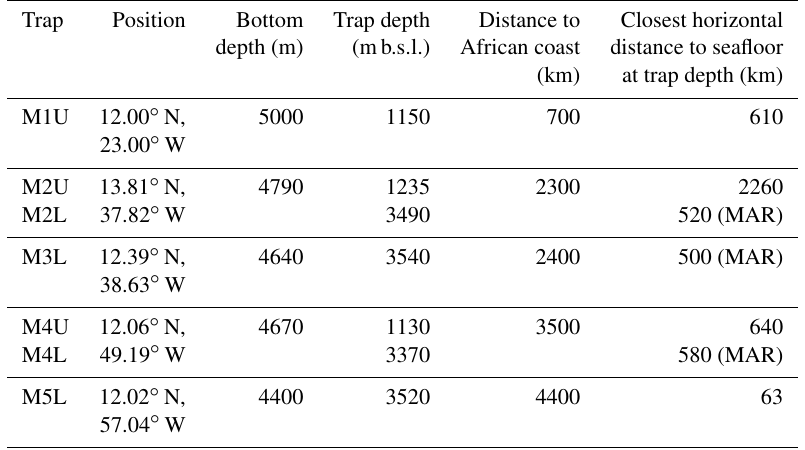
Table 2. Sediment trap details. Sampling was performed simultaneously and synchronously from 19 October 2012 until 7 November 2013 (384 days). Trap Position Bottom Trap depth Distance to Closest horizontal depth (m) (mb.s.l.) African coast distance to seafloor (km) at trap depth (km) M1U 12.00 ◦ N, 5000 1150 700 610 23.00 ◦ W M2U 13.81 ◦ N, 4790 1235 2300 2260 M2L 37.82 ◦ W